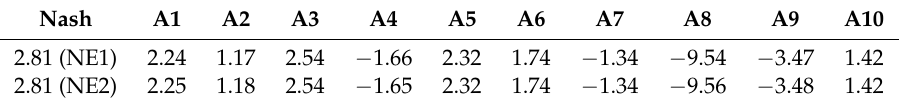
Table 4. Experiments using Nash agents against class project agents. The values reported are the total overall payoff of the agent in dollars (assuming an ante of $1 and a bet size of $1), divided by 100,000. Nash A1